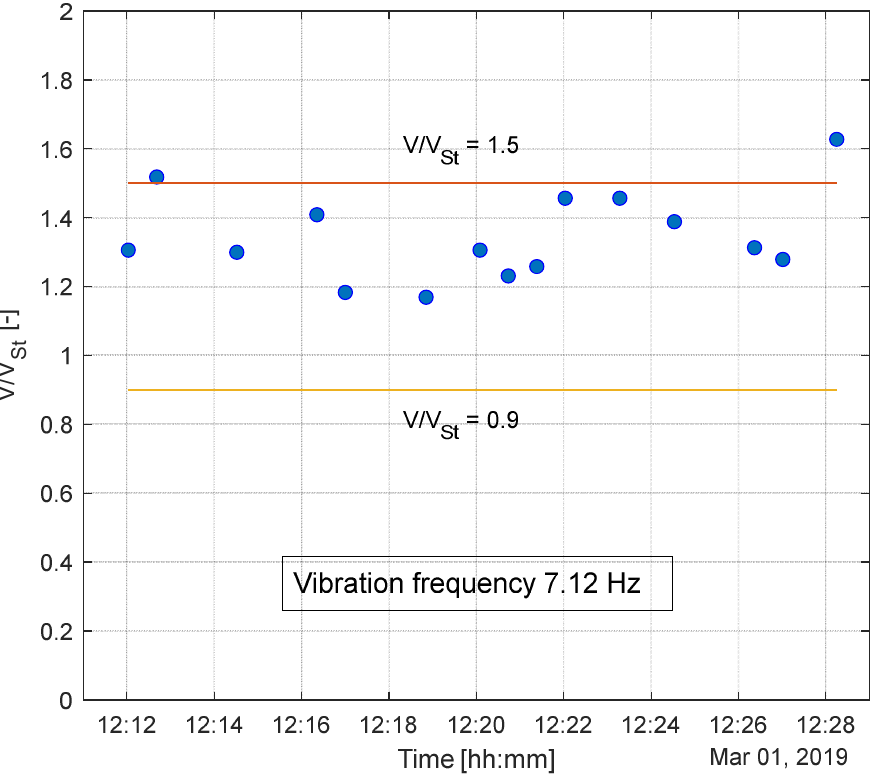
Figure 16. Experimental data referring to the lock-in condition characterizing the vortex shedding phenomenon with a focus on the synchronization range.